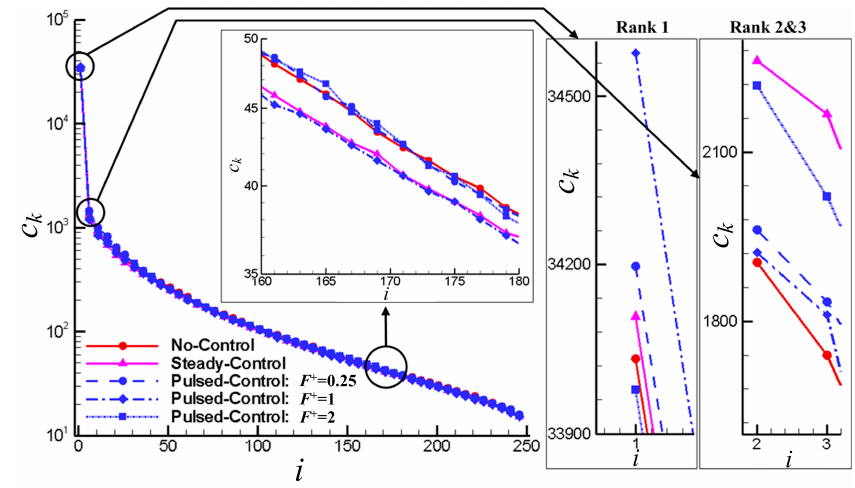
Figure 16. Energy ratio spectra without flow control, with steady and different frequency pulsed jet controls.